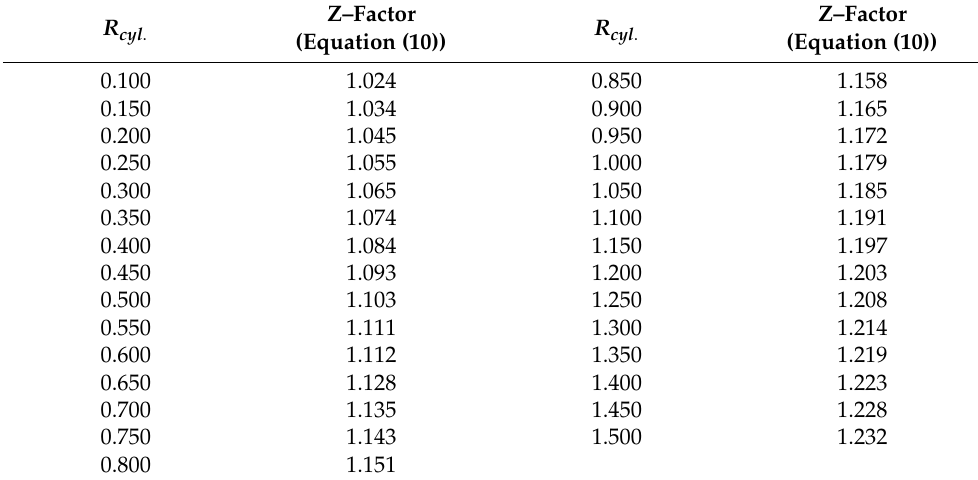
Table 1. Correction factor Z for the interaction between a sphere and a cylinder. R cyl